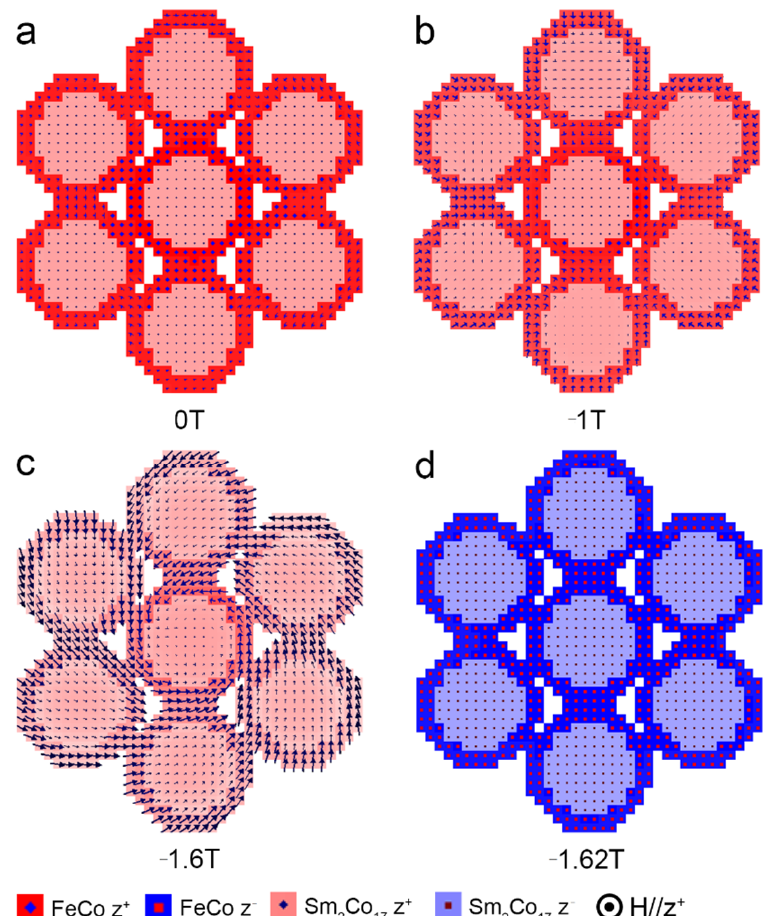
Figure 8. Magnetic structure at the applied field of ( a ) 0 T, ( b ) − 1 T, ( c ) − 1.6 T, ( d ) − 1.62 T during demagnetization for a hexagonal close-packed array of core/shell cylinders with t = 2 nm. The observation plane is perpendicular to the applied field.